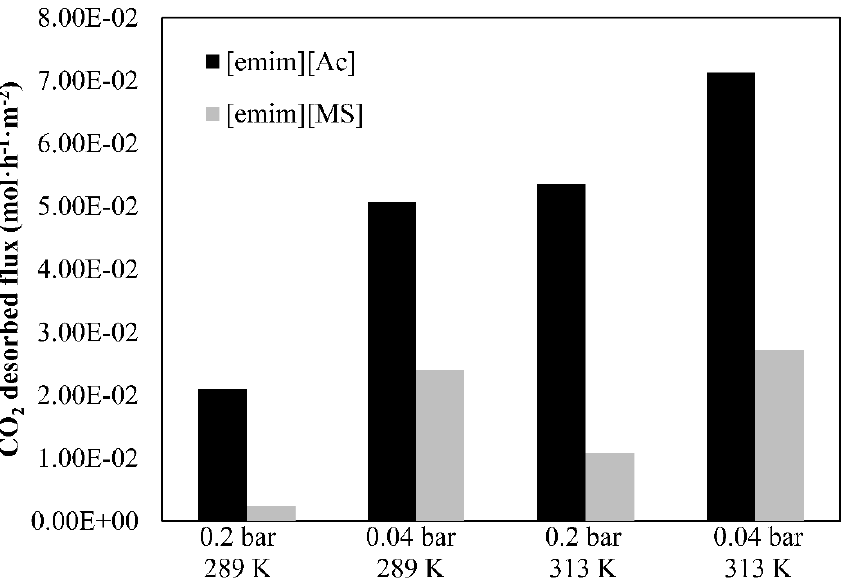
Figure 7. CO 2 desorbed flux by using 2 ILs at different vacuum pressures and temperatures. Com- mercial HFMC operational conditions: liquid flow rate 60 mL·min-1.